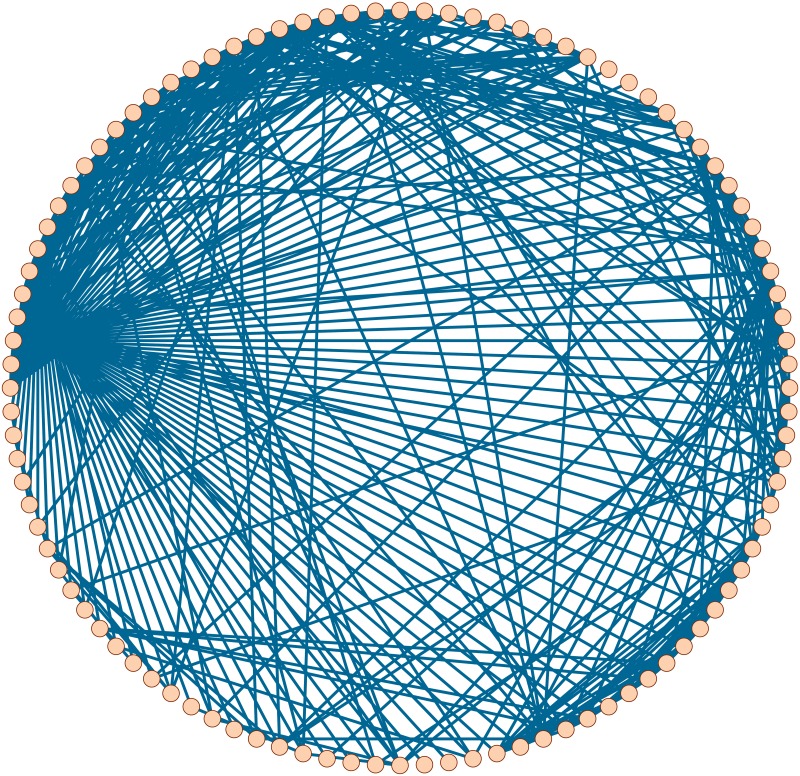
A realistic email network GEM.